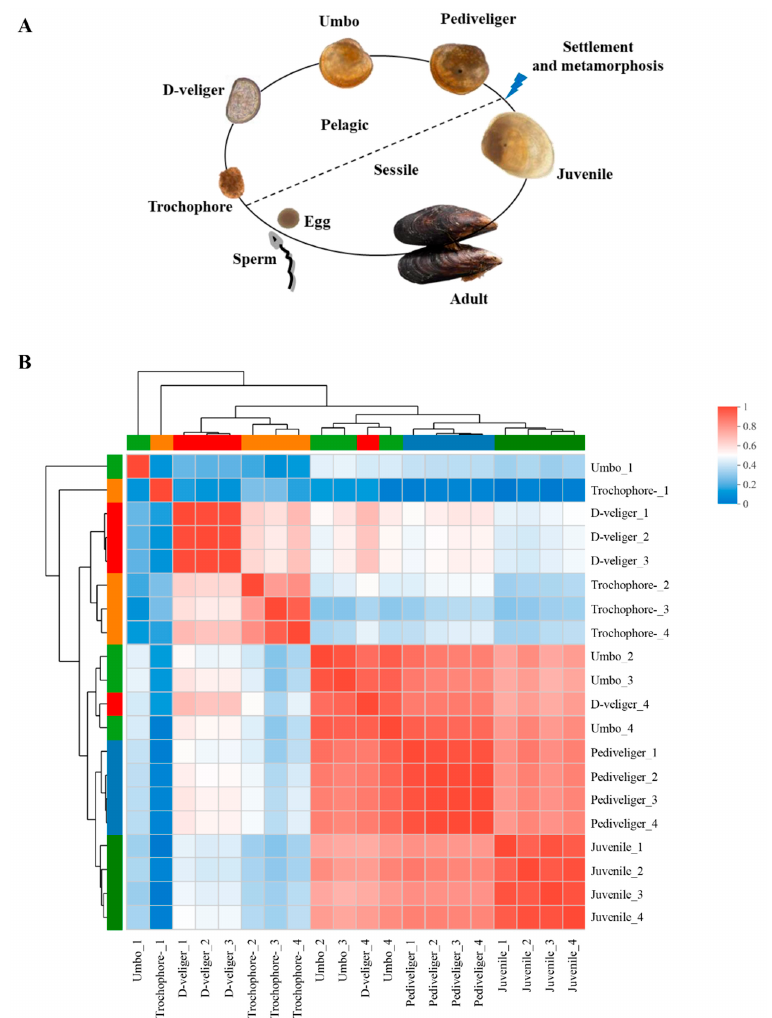
Figure 2. The life cycle of the mussel M. coruscus ( A ) and heat map for the Pearson correlation coefficient for all 20 samples ( B ). The heat map plots the correlation coefficient score between any two samples. The color of a square represents each coefficient in the correlation matrix. The color scale used is blue to red, with blue representing 0 and red representing 1. The five clusters defined by hierarchical clustering are indicated at the top.